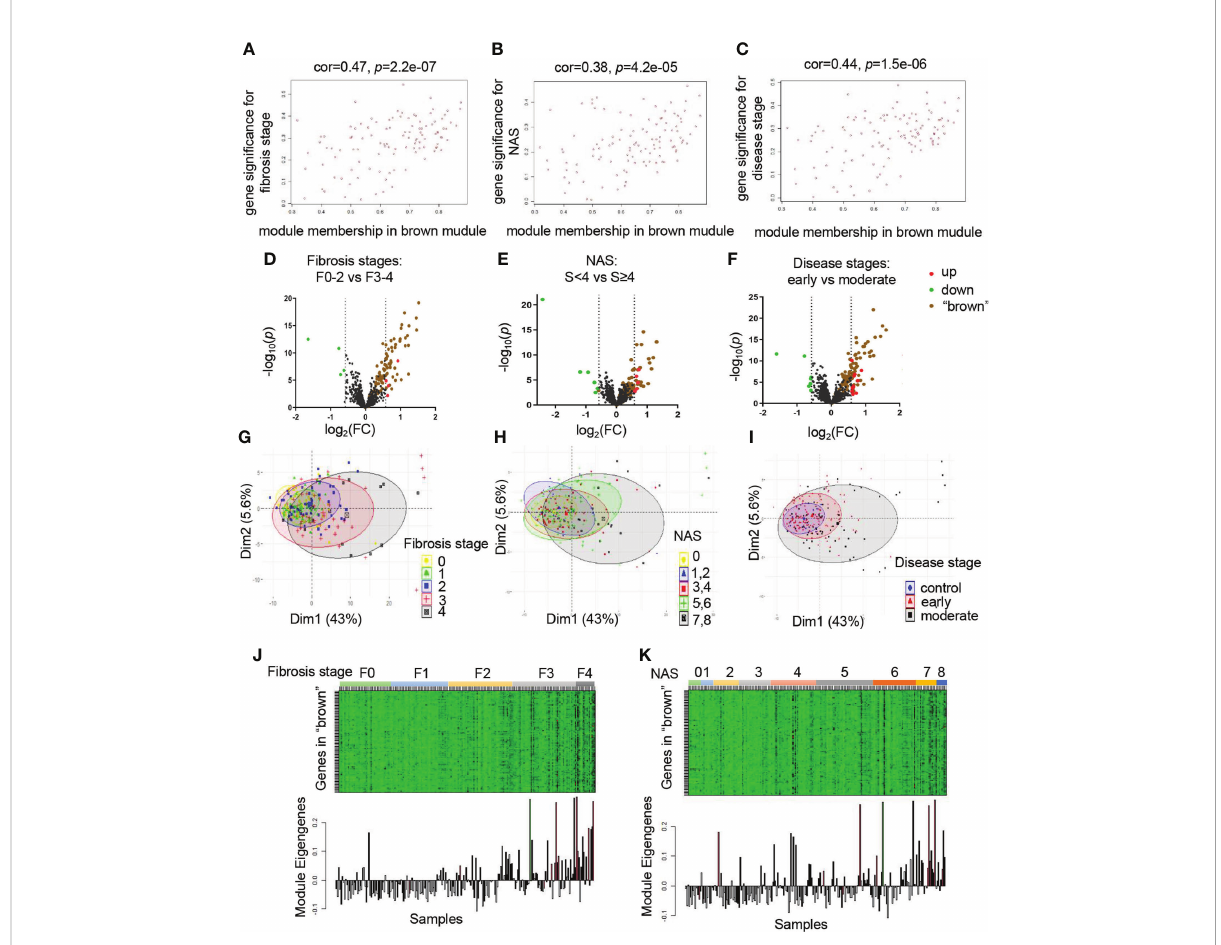
FIGURE 2 The brown module is signi fi cantly correlated with clinical traits. (A – C) Correlation between MM in brown module and GS for fi brosis stages (F0- F4) (A) , NAS (0-8) (B) , disease stages (control, early and moderate) (C) are calculated. Corresponding Pearson correlation coef fi cients and P values are displayed. (D – F) Volcano plots to visualize differential expression patterns between groups based on fi brosis stages, NAS and disease stages, respectively. Genes up-regulated (FC>1.5, p value <0.05) are depicted in red dots and those down regulated (FC<0.66, p value <0.05) are depicted in green dots. All the genes from brown module are shown in brown dots. The rest of genes without signi fi cant difference are shown in black dots. (G – I) PCA analysis of the genes from brown module. The points represent samples based on the top two principal components of gene expression pro fi les. The colors represent groups of samples based on fi brosis stages, NAS and disease stages, respectively. (J, K) The relationship of gene expression feature of brown module and fi brosis stages, NAS, respectively. The heatmaps represent gene expression of brown module in each sample. The bar graphs represent the module eigengenes of brown module in the corresponding samples. GS, gene signi fi cance; MM, module membership; PCA, principal component